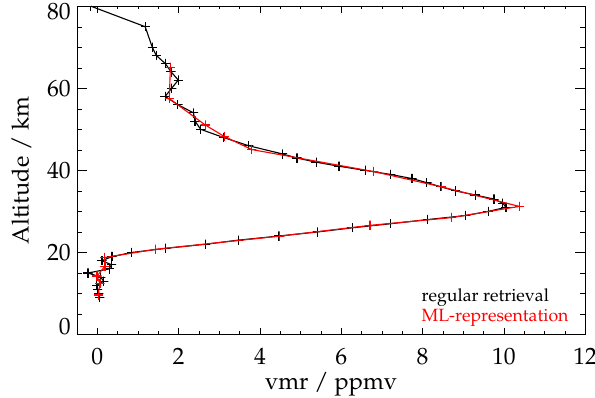
Figure 1. A MIPAS ozone profile from the regular processing (black) and the same profile in a maximum likelihood representa- tion where linear interpolation of vmr between altitude grid points was assumed (red). This particular example is a measurement at 17.75 ◦ S, 96.70 ◦ W on 02 October 2009. The original retrieval has 20.6 degrees of freedom, yielding 19 steps in the maximum likeli- hood representation, of which 17 are actually free of formal prior information. The regular MIPAS ozone data product used here has been validated by Laeng et al. (2014,